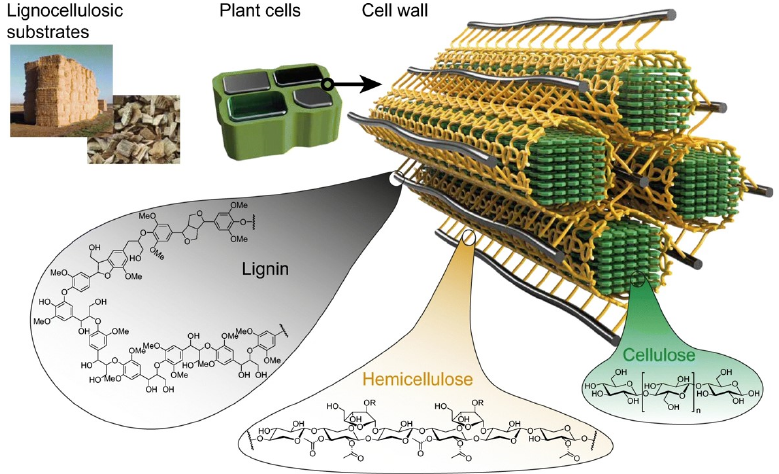
Figure 7. Schematic model of cellulose, hemicellulose, and lignin arrangement in lignocellulosic sources, [56] .